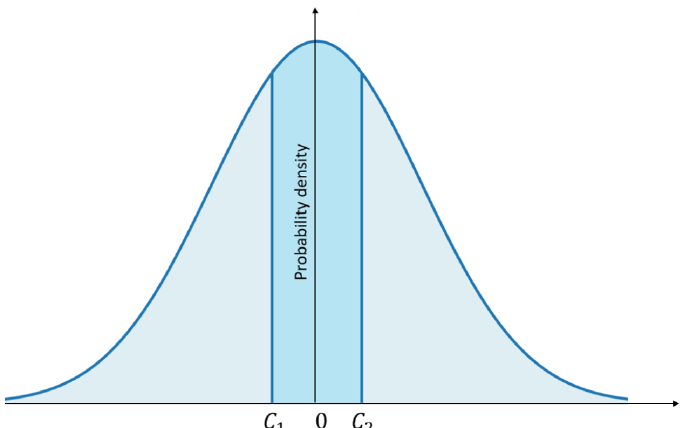
Figure 2. Probability density function of a latent random variable to be converted into a three-value discrete random variable. The two cutoffs, namely c 1 and c 2 , split area under the curve into three regions associated with three feature outcomes with the same